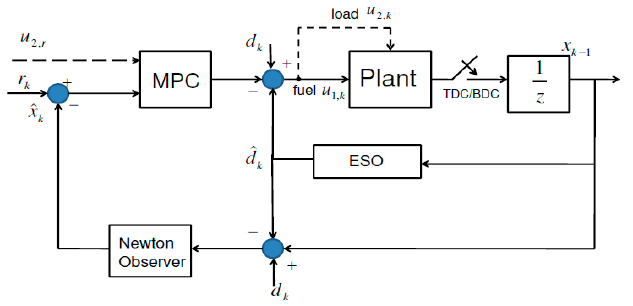
Figure 29. Control scheme of model predictive control [50].